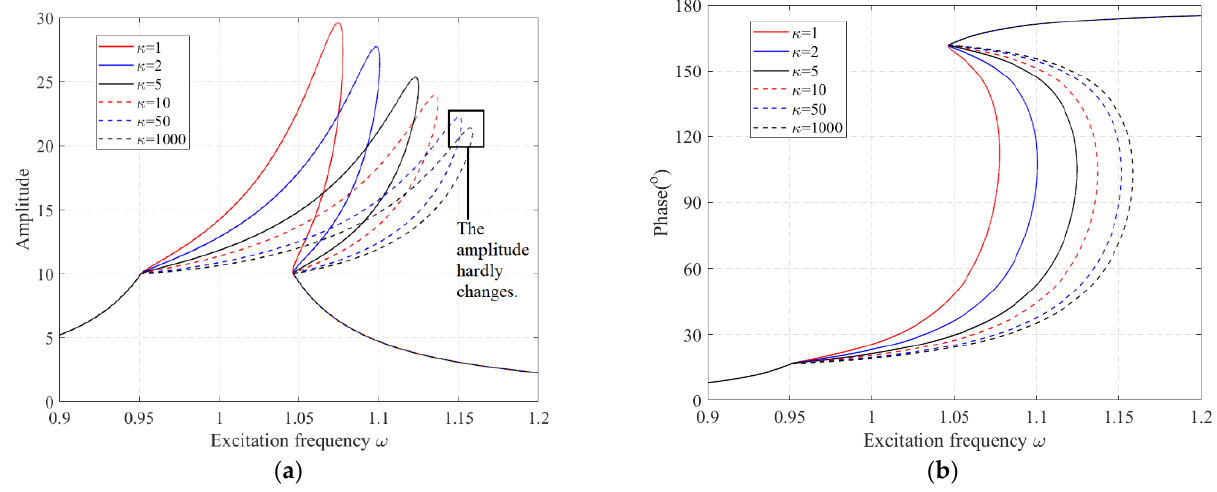
Figure 16. Influences of κ on amplitude–frequency and phase–frequency characteristics of Dof-1: ( a ) amplitude–frequency characteristics; ( b ) phase–frequency characteristics.